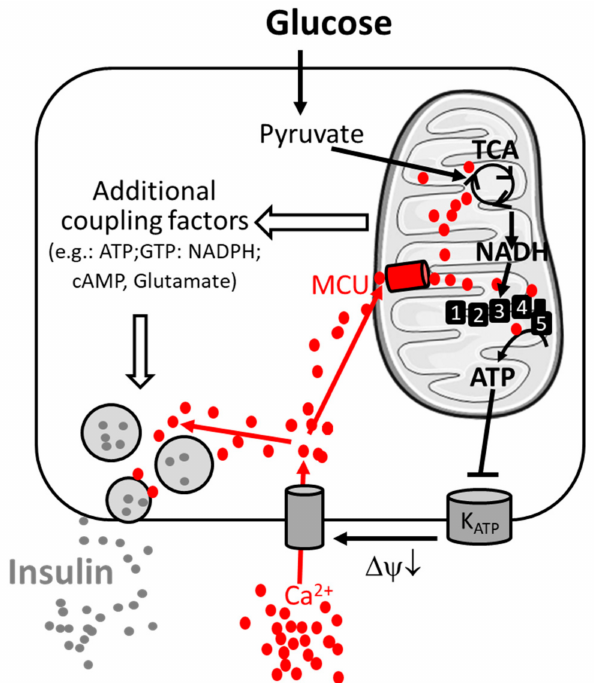
Figure 1. Consensus model of the signal transduction pathway of pancreatic β -cells. Metabolism– secretion coupling of β -cells requires the sequential activation of glycolysis, mitochondrial oxidative metabolism and Ca 2+ entry through the plasma membrane. Glucose stimulates glycolysis and pyruvate production. Pyruvate triggers mitochondrial metabolism and the formation of the reduced form of nicotinamide adenine dinucleotide NADH (by the TCA cycle), which is the fuel for the respiratory complexes (1,2,3,4), enabling ATP production by ATP-synthase (5). ATP inhibits the K ATP channel, inducing membrane depolarization ( ∆Ψ ↓ ) and Ca 2+ entry through voltage-gated Ca 2+ channels, promoting insulin secretion. Ca 2+ is taken up in parallel by mitochondria via the mitochondrial Ca 2+ uniporter (MCU) and facilitates sustained insulin secretion. The amplifying pathway of metabolism–secretion coupling is co-generated by additive coupling factors. Additional players contributing to Ca 2+ homeostasis are mentioned in the main